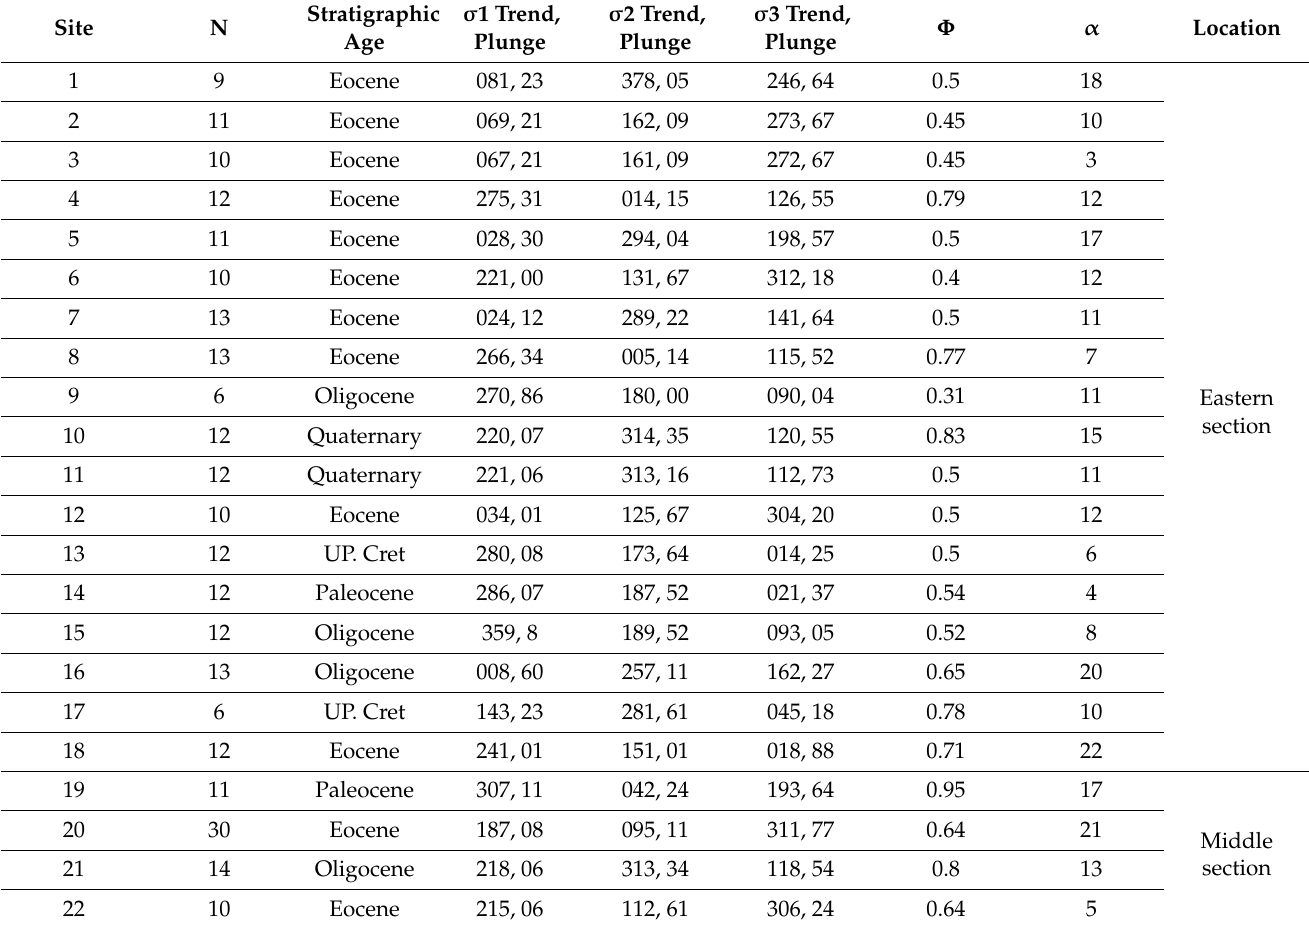
Table 2. Reconstructed stress regimes and geological situation of brittle structures. N, number of data on the fault-slips. Φ , ratio of stress magnitude differences ( Φ = ( σ 2 − σ 3)/( σ 1 − σ 3)). α , the average angle between the calculated shear and observed slip in